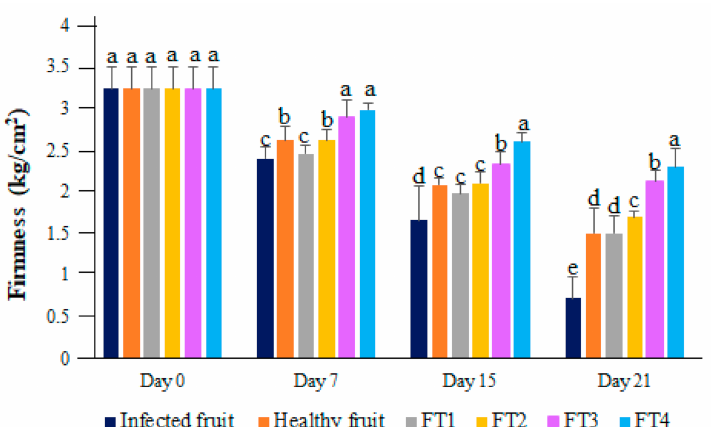
Figure 4. Firmness of avocadoes treated with the films FT1–FT4 after inoculation with Clonos- tachys rosea . Bars with different letters indicate means with statistically significant differences by ANOVA-Tukey test ( p <